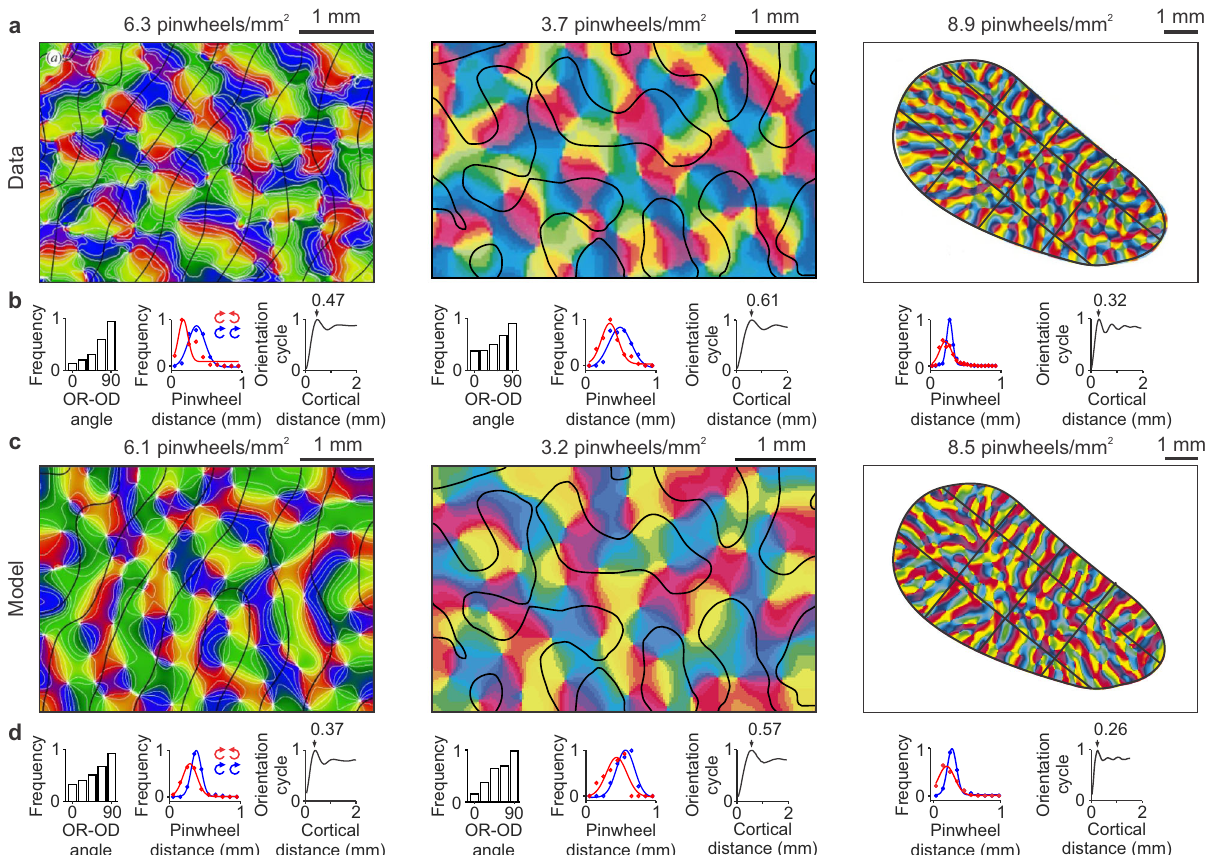
Fig. 7 Model simulations of cortical orientation maps in three different species. a Maps of stimulus orientation and pinwheel density experimentally measured in the visual cortex of a macaque (left), a cat (middle) and a tree shrew (right). Reproduced with permission from Horton and Adams, 2005 (original data from Blasdel, 1992), Hubener et al., 1997, and Bosking et al., 1997. The black lines illustrate ocular dominance borders in the macaque and cat visual cortex and iso-retinotopic lines in the tree shrew. b Statistics of the three orientation maps from ( a ) showing, for each animal, from left to right, distribution of angles between iso-orientation lines and ocular-dominance borders (in macaque and cat, tree shrews do not have ocular dominance borders), distance between pinwheels with same (blue) or opposite (red) rotations, and orientation map periodicity. c – d Model simulations of the experimental data from ( a – b ) (using the same color map as the published data). Source data are provided as a Source Data fi